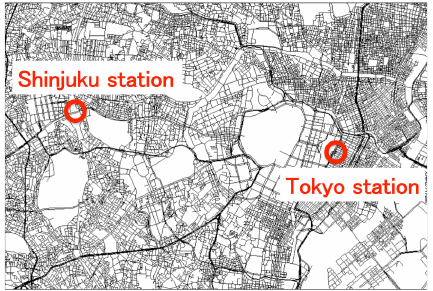
Figure 5. Flowchart of the proposed route generation algorithm